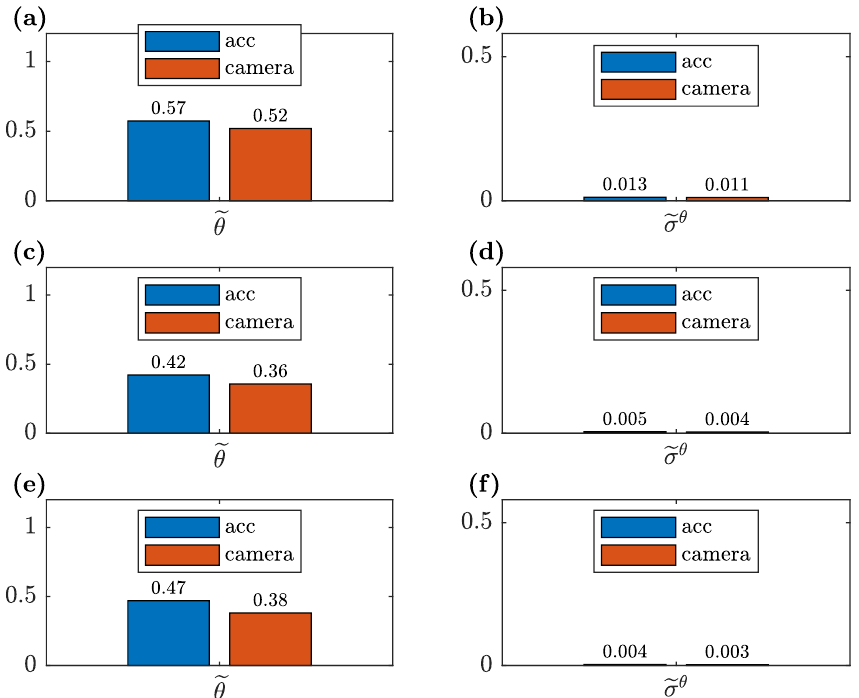
Figure 15. Comparison of the unknown parameters θ 1 and θ 2 of the updated FE model obtained from the CV- and accelerometer-based data and the corresponding expected standard deviations σ θ for: ( a , b ) only the first identified mode available; ( c , d ) the two first identified modes available and ( e , f ) all three modes available for model updating.